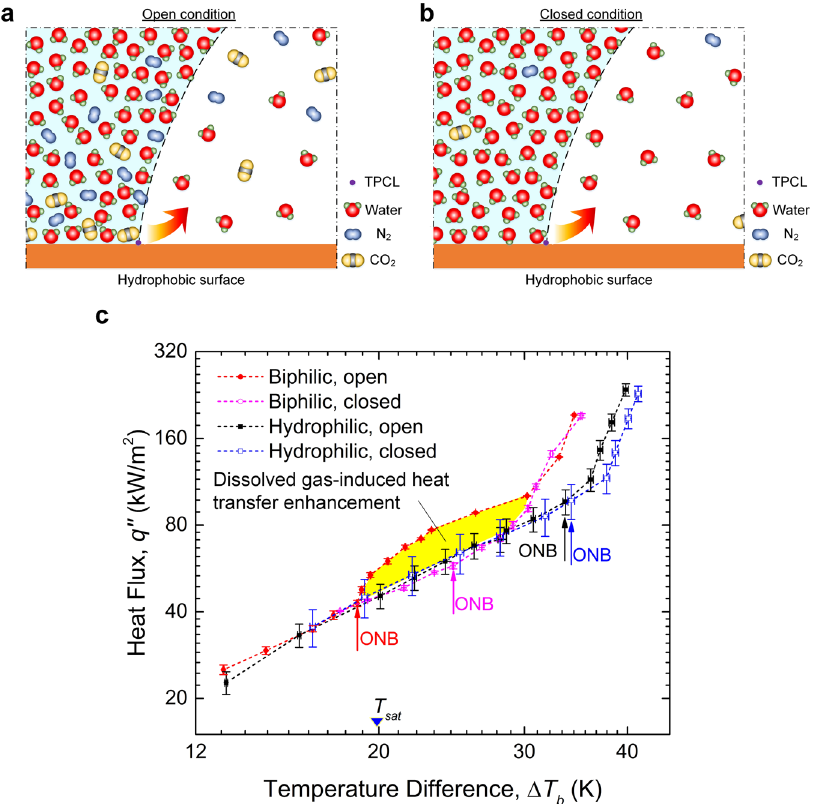
Figure 8. Different mechanisms of bubble generation on a hydrophobic surface and their impact on heat transfer. ( a ) Bubble nucleation in the open system. A considerable amount of gas is believed to aggregate near the hydrophobic surface even when the bulk liquid is nearly depleted of incondensables following boiling deaeration. The liquid phase with such high concentrations of dissolved air tends to become metastable at significantly lower superheats, which allows a mixture of vapour and gas contents to be liberated through the three-phase contact line (TPCL) into the growing bubble. ( b ) Bubble nucleation in the closed system. Under reduced external pressures, the gas enrichment tends to form larger nanobubbles on the hydrophobic surface, the constant merging of which facilitates eventual removal. As a result of the less formidable presence of dissolved gas, vapour bubble nucleation follows the conventional route irrespective of the surface hydrophobicity. (c) Comparison of the boiling curves of the biphilic (PTFE/TiO 2 ) surface under the open and closed conditions and that of the uniformly superhydrophilic (TiO 2 ) surface under similar conditions. The boiling incipience occurred on the biphilic surface at Δ T sat = − 1.6 K in the open system and Δ T sat = 2.9 K in the closed system, respectively; on the other hand, ONB on the hydrophilic surface was measured to be Δ T = 13.9 K in the open system and Δ T = 14.2 K in the closed system, respectively. It would appear that sat sat compared with the very different boiling curves of the biphilic surface, the results of the TiO 2 surface varied little between the open and closed conditions, denoting little effect of dissolved gas. The significant gap between the boiling curves of the open and closed systems of the biphilic surface (shaded by yellow) represents the impact of the gas accumulation on heat transfer in the low-superheat